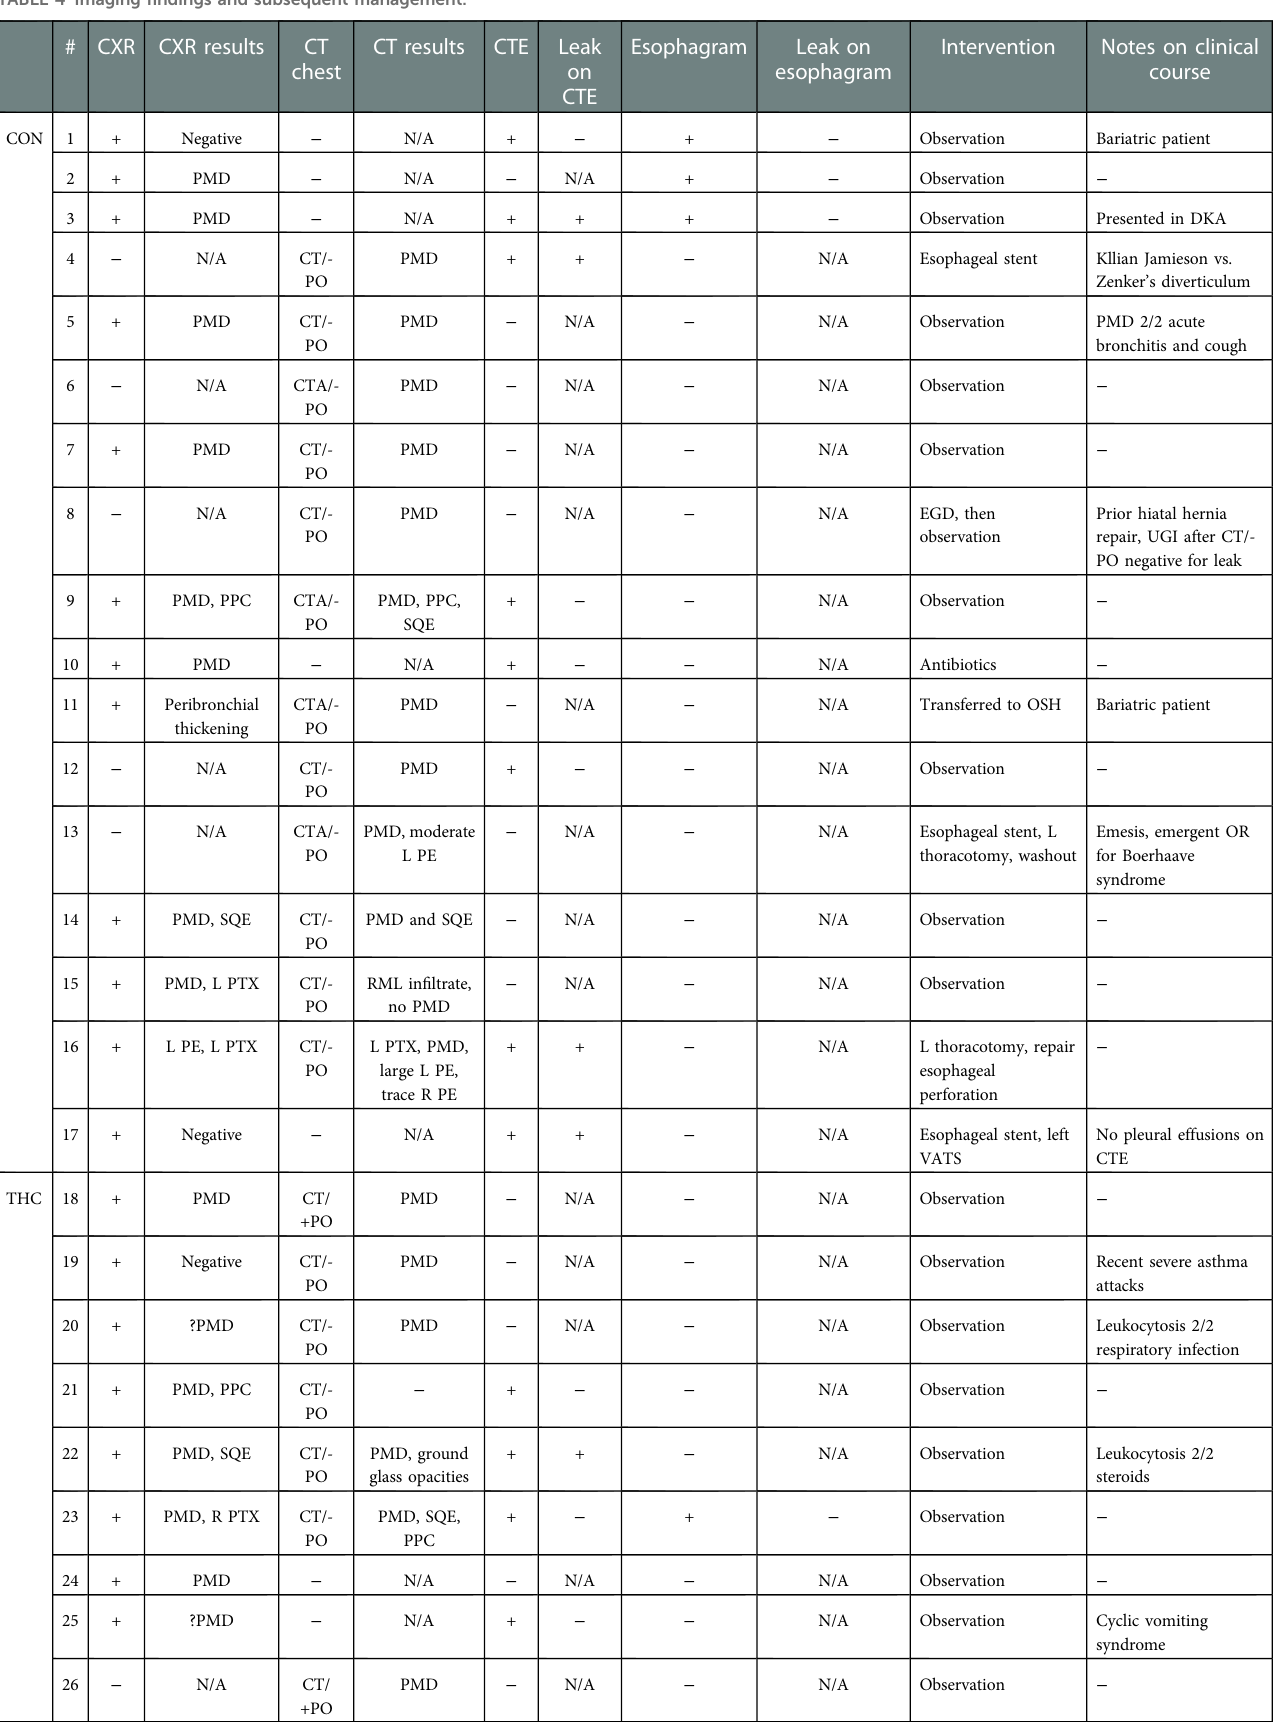
TABLE 4 Imaging fi ndings and subsequent